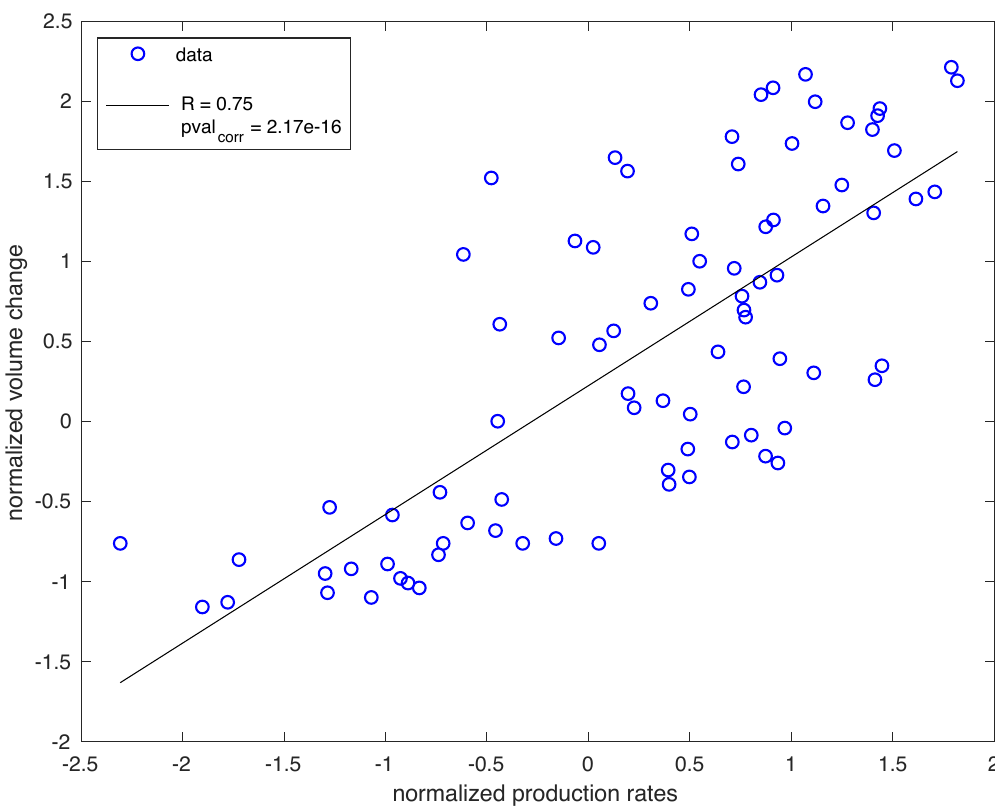
Figure 13. Scatter plot showing the monthly volume change estimated from temporal adjustment of InSAR data and monthly gross production